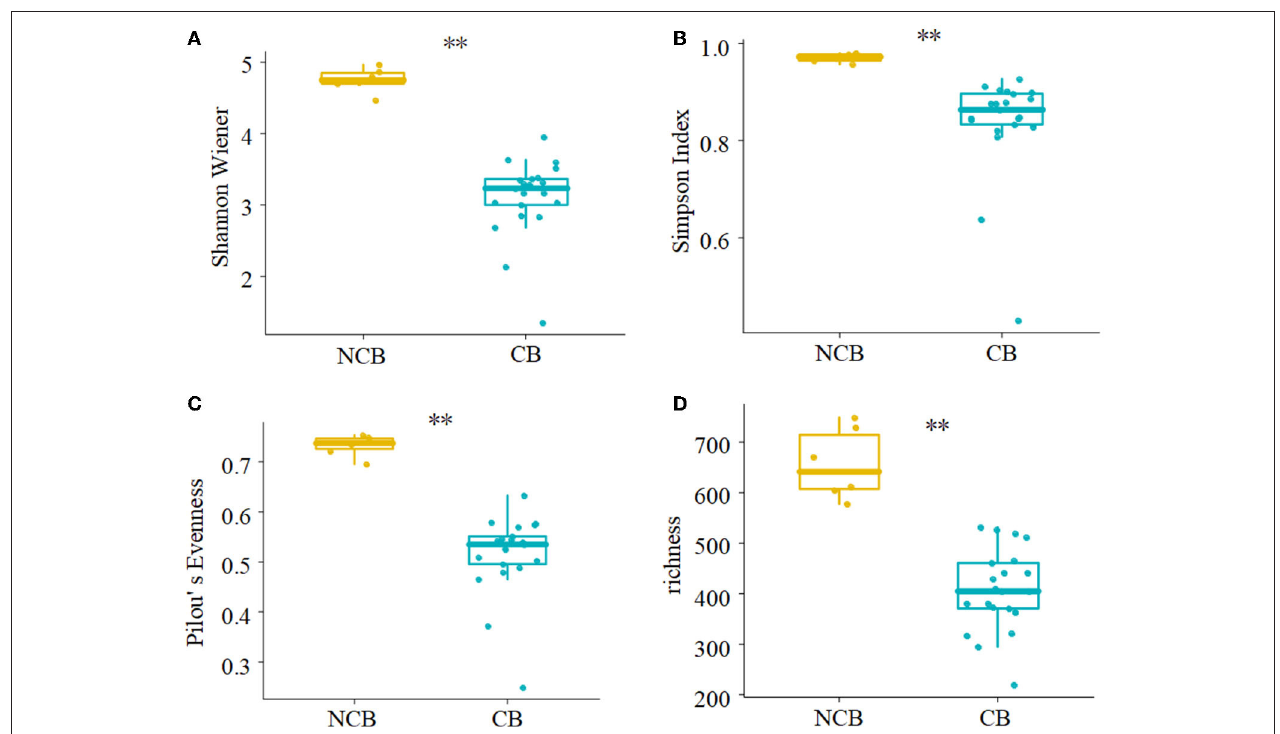
FIGURE 3 | Comparison of alpha diversity indices of gut microbiota between non-cyanobacterial bloom (NCB) and cyanobacterial bloom (CB) periods. (A) Shannon-Wiener index, (B) Simpson index, (C) Pilou’s evenness, (D) richness. ** P < 0.01.